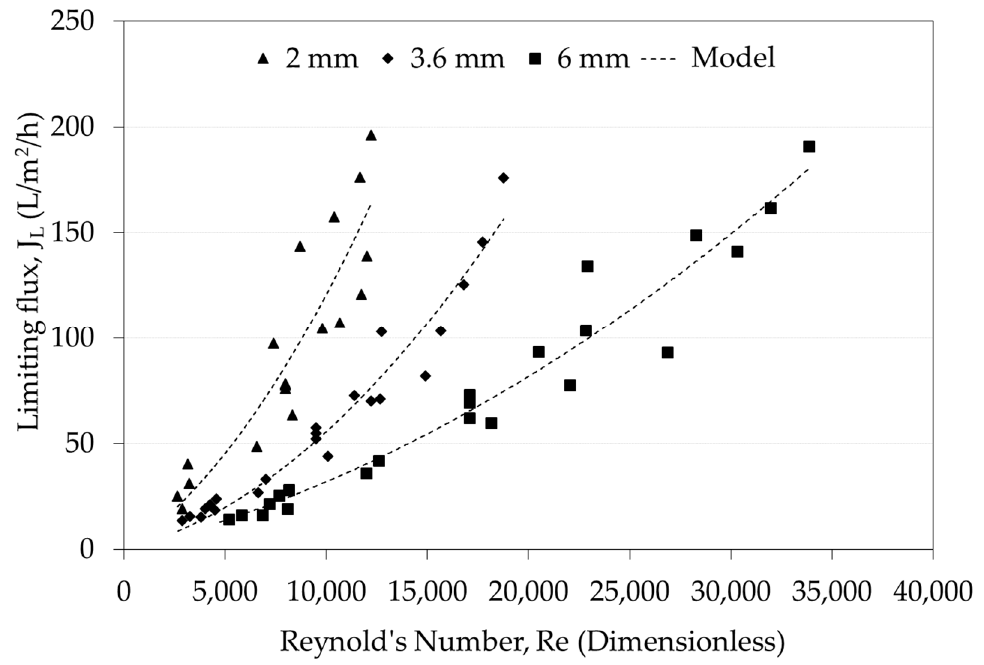
Figure 6. Limiting flux versus Reynolds number curves during skim milk microfiltration for three hydraulic diameters (2, 3.6, and 6 mm). Model type: J L = (aRe + b) Re.